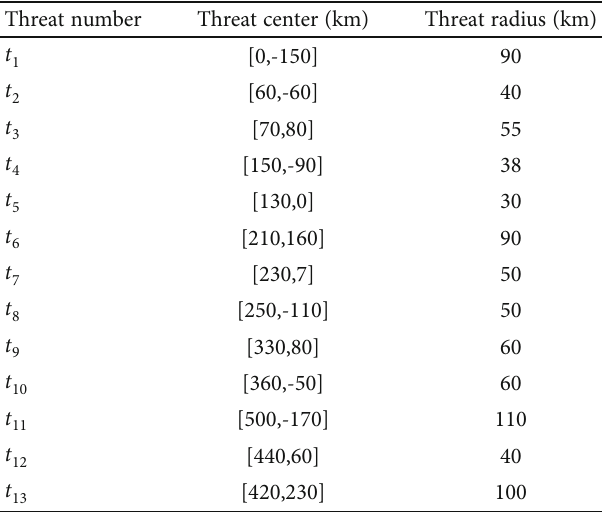
Table 2: The information of threat